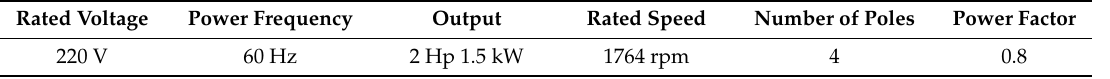
Figure 8. Stator winding inter-turn short circuit.